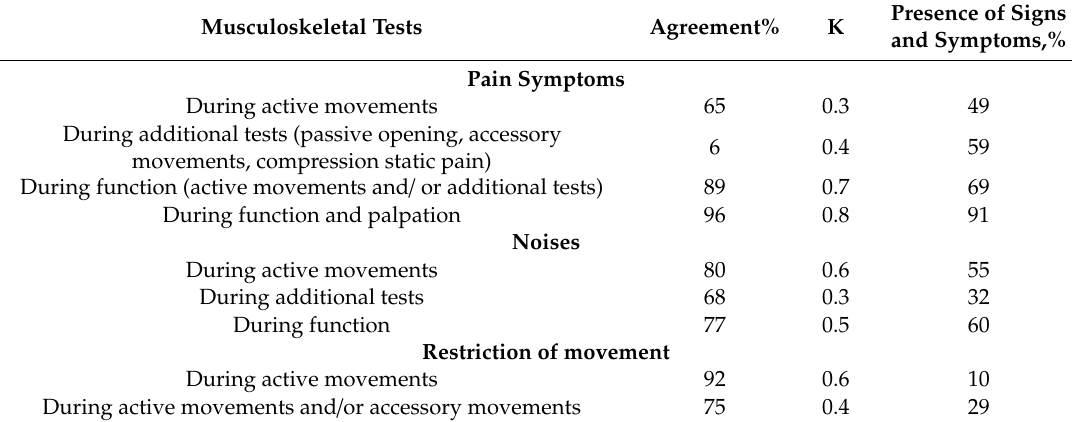
Table 1. Inter-examiner reliability of musculoskeletal tests related to the three main symptoms of TMD (adapted from Steenks et al.,